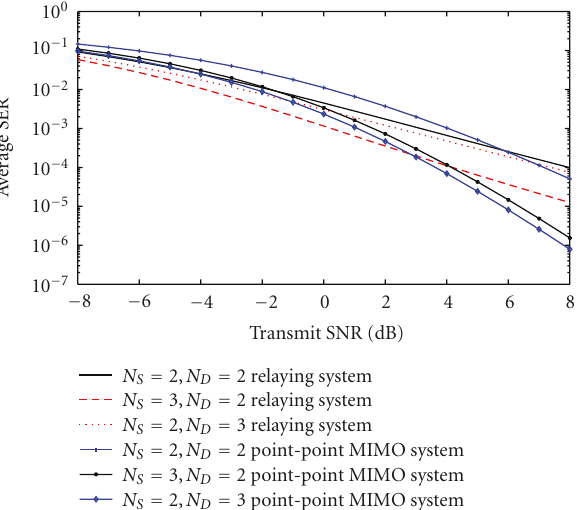
Figure 5: Average SER comparison between the relaying system and MIMO point-to-point system.